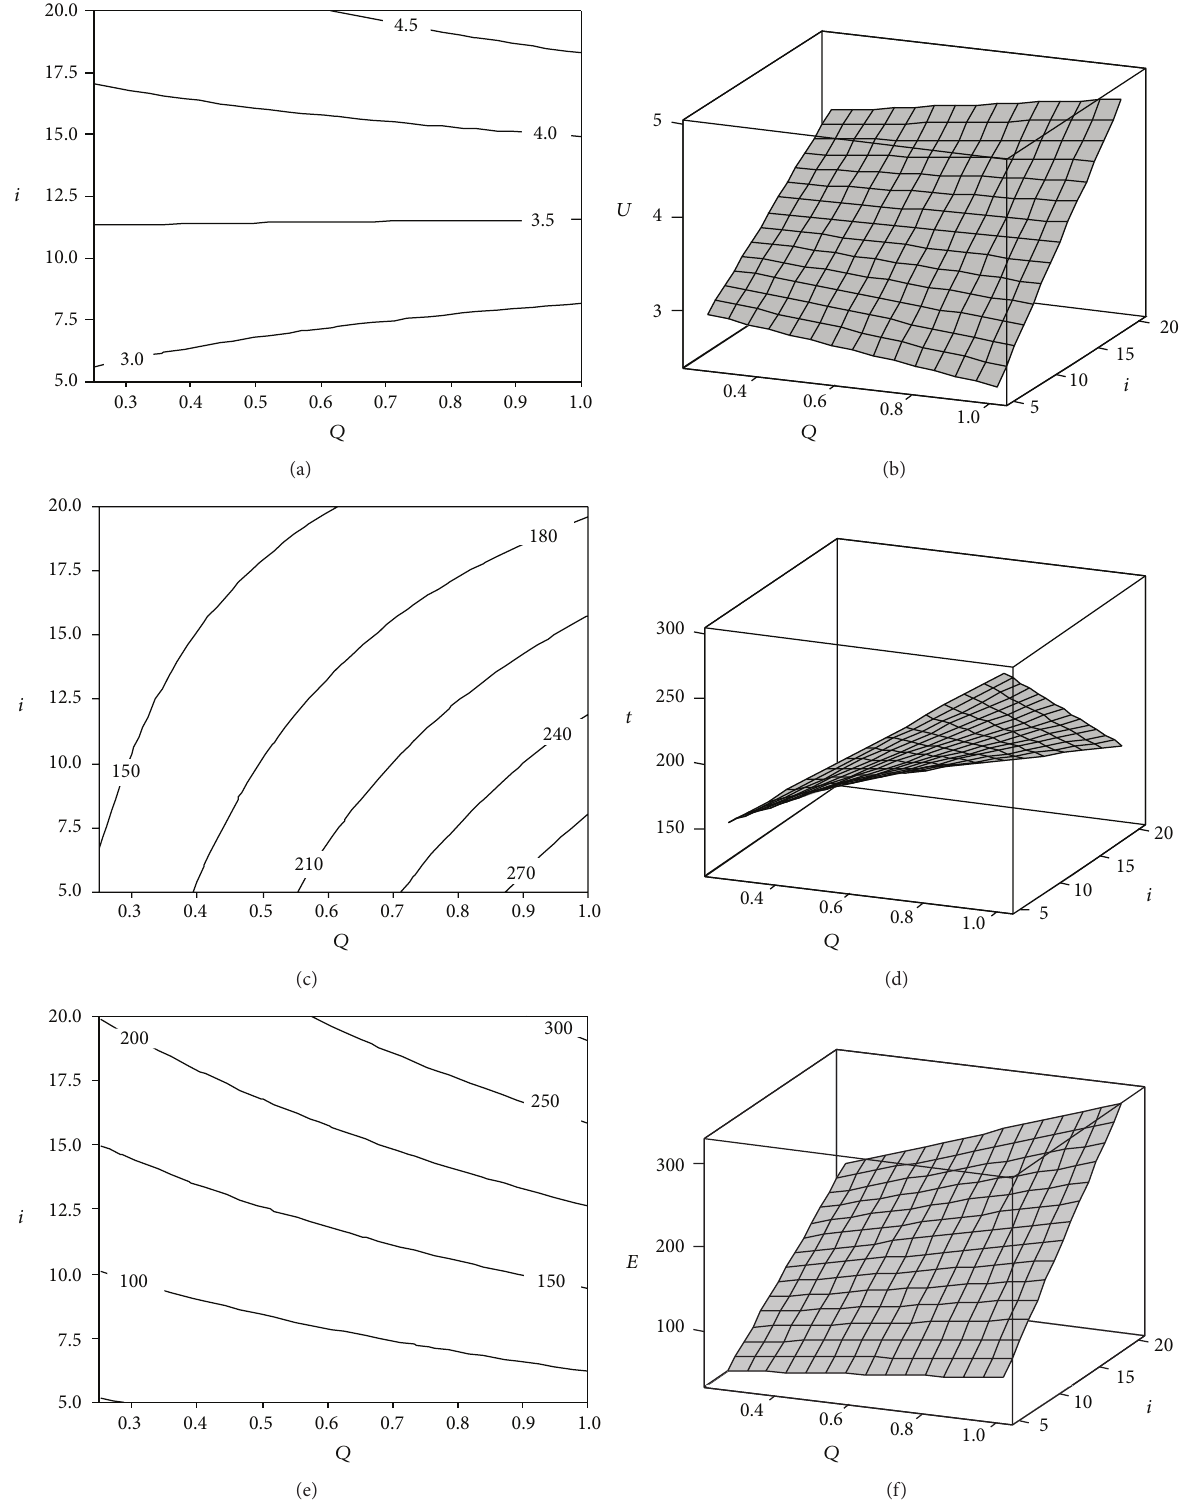
Figure 9: (a) Contour surface plot and (b) response surface, showing the interactive effect of feedwater flow rate 𝑄 (0.25–1.00 L min −1 ) and current density 𝑖 (5–20 Am −2 ) on the total potential drop 𝑈 measured in the EC reactor. (c) Contour surface plot and (d) response surface, showing the interactive effect between the independent variables, feedwater flow rate 𝑄 (0.25–1.00 Lmin −1 ), and current density 𝑖 (5–20 Am −2 ) on the treatment time 𝑡 required to achieve an As concentration of 10 𝜇 gL −1 during the EC process. (e) Surface contour plot and (f) surface response, showing the interactive effect of the independent variables, feedwater flow rate 𝑄 (0.25–1.00 Lmin −1 ), and current density 𝑖 (5–20Am −2 ) on energy consumption 𝐸 during the EC